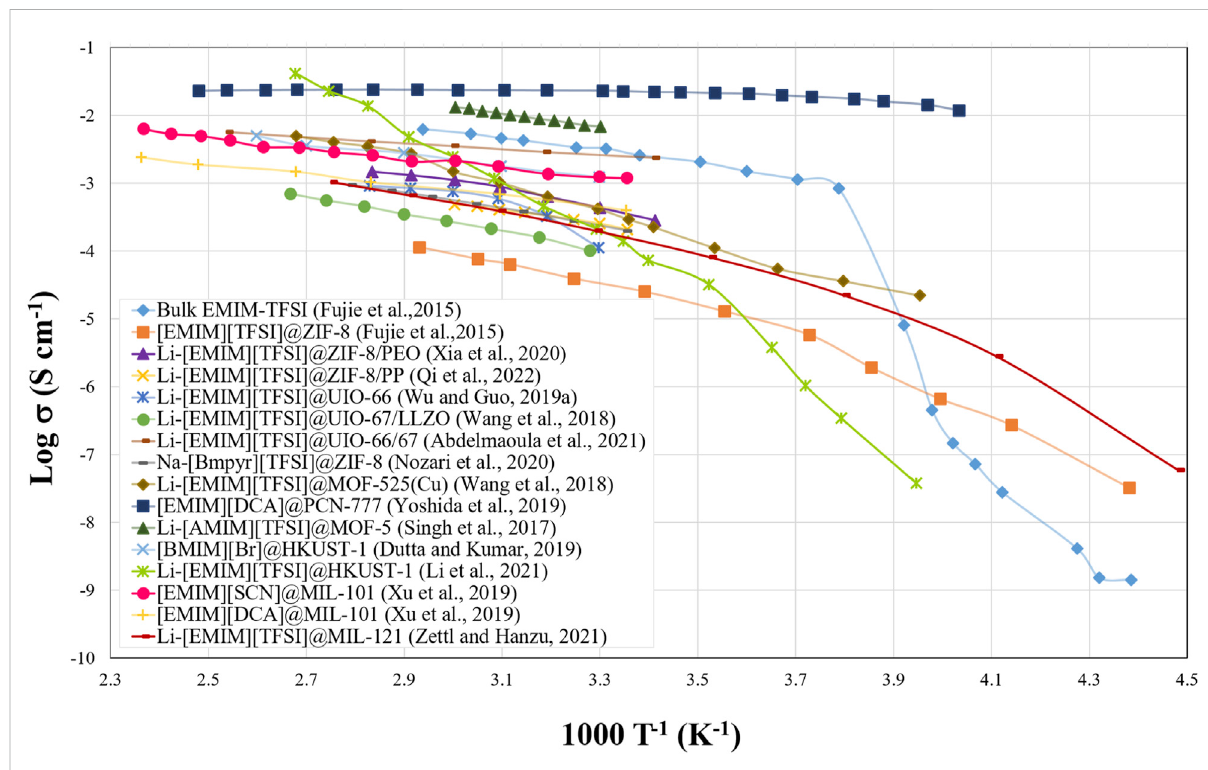
FIGURE 6 Plot of ionic conductivities versus temperature for different IL@MOF hybrid